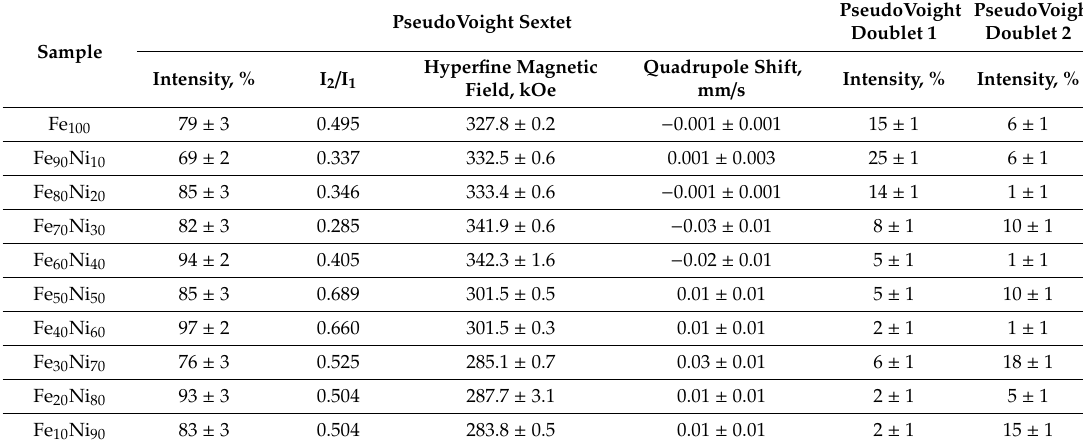
Table 2. The data for hyperfine